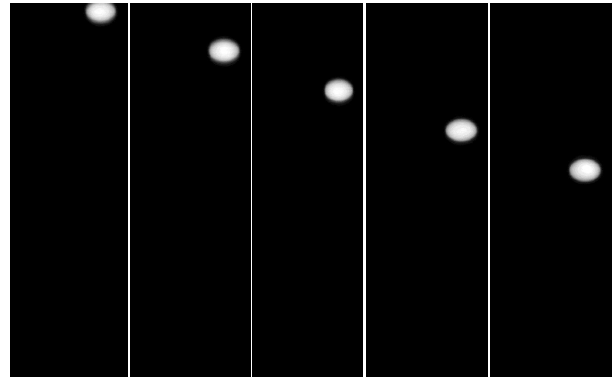
Figure A1. Sequential images of the Sun captured by one of visible channels through the albedo monitor onboard COMS/MI